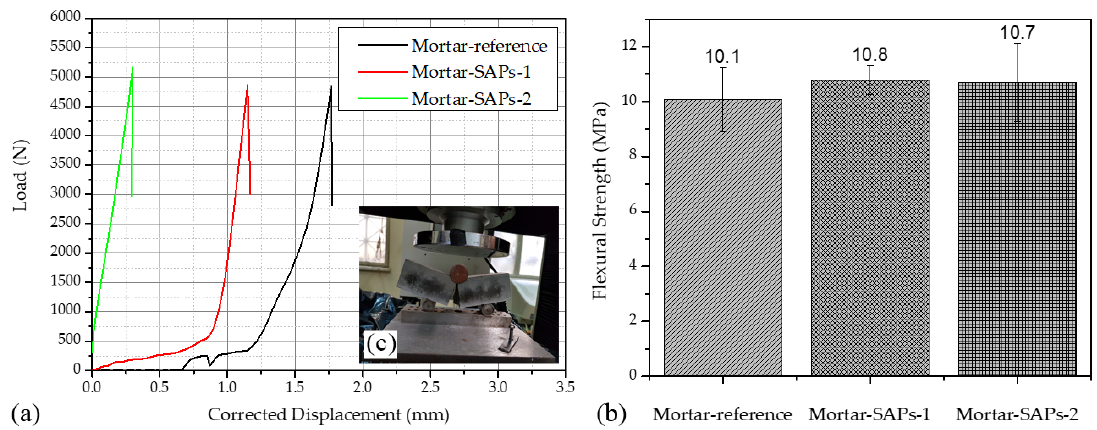
Figure 4. Maximum values of loads for mortar specimens at 28 days of age ( a ), flexural strength of mortar specimens at 28 days of age ( b ), optical image of specimen after flexural test ( c ).